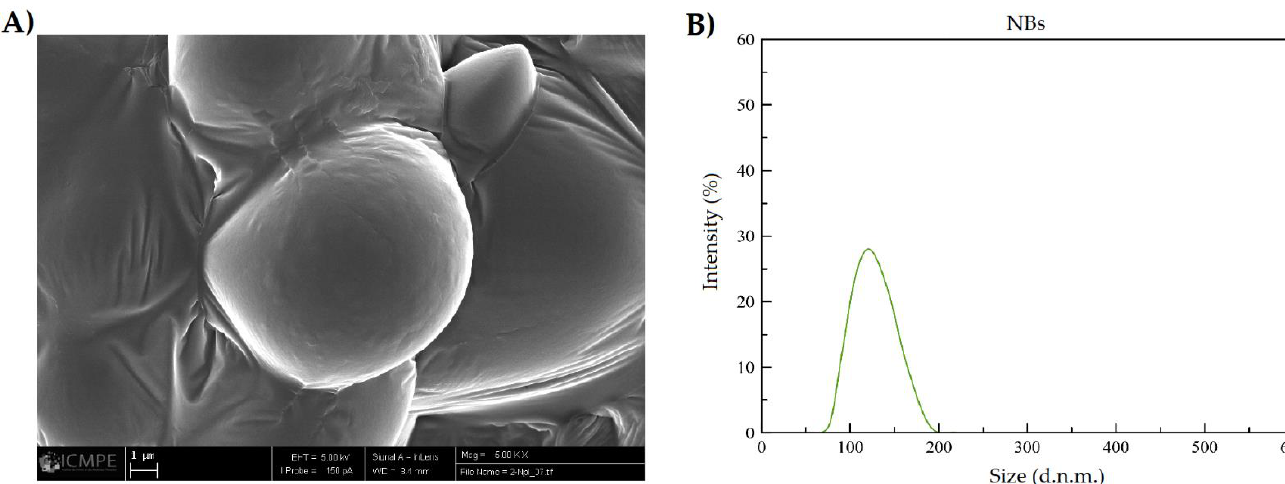
Figure 6. Size characterization of non-charged nanoparticles. ( A ) SEM image of inulin non-charged nanoparticles (NBs) (5000× magnification, scale 1 µm). ( B ) DLS NBs reconstituted in organic sol- nanoparticles (NBs) (5000 × magnification, scale 1 µ m). ( B ) DLS NBs reconstituted in organic solvent vent (absolute ethanol). (absolute ethanol).